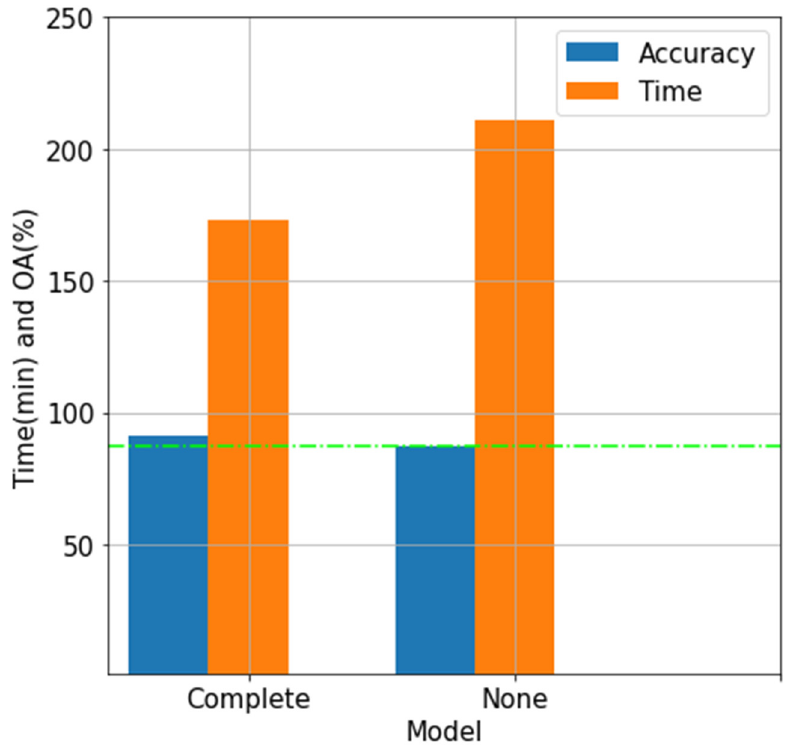
Figure 9. Training time and OA of the DBMF method with sandglass block and none.